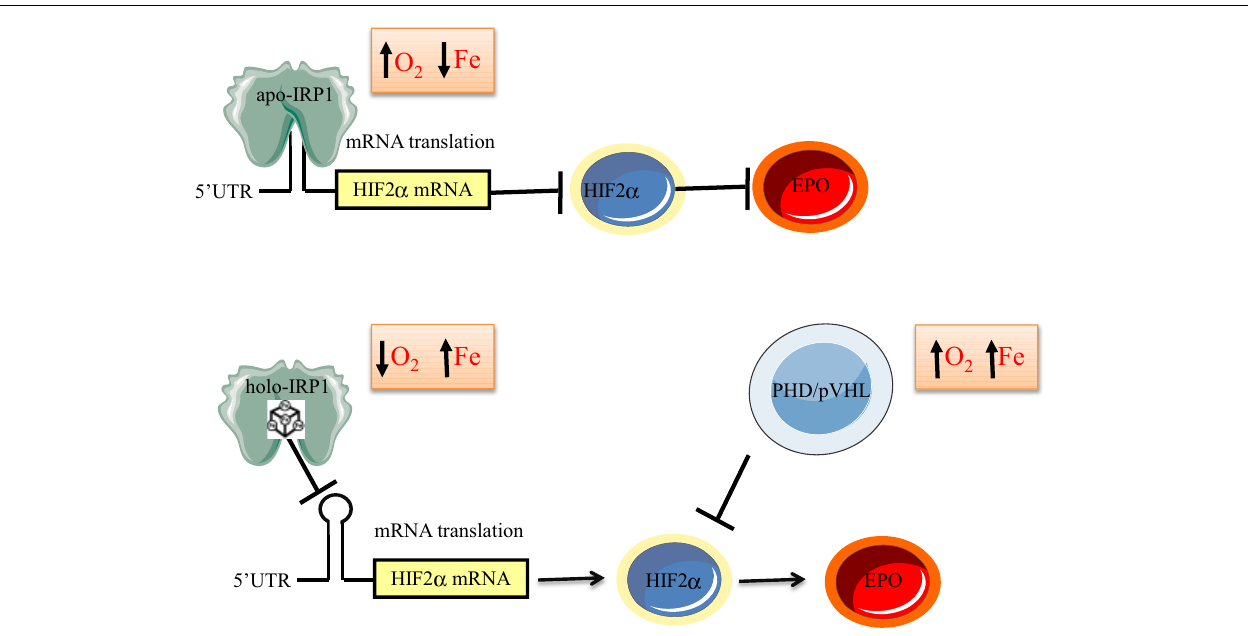
FIGURE 6 | Model for regulation of erythropoiesis by IRP1 via the HIF2 α /EPO axis. In iron-deficient or normoxic cells, apo-IRP1 limits HIF2 α synthesis by binding to HIF2 α mRNA. Iron-replete conditions favor conversion of apo- to holo-IRP1, at the expense of its IRE-binding